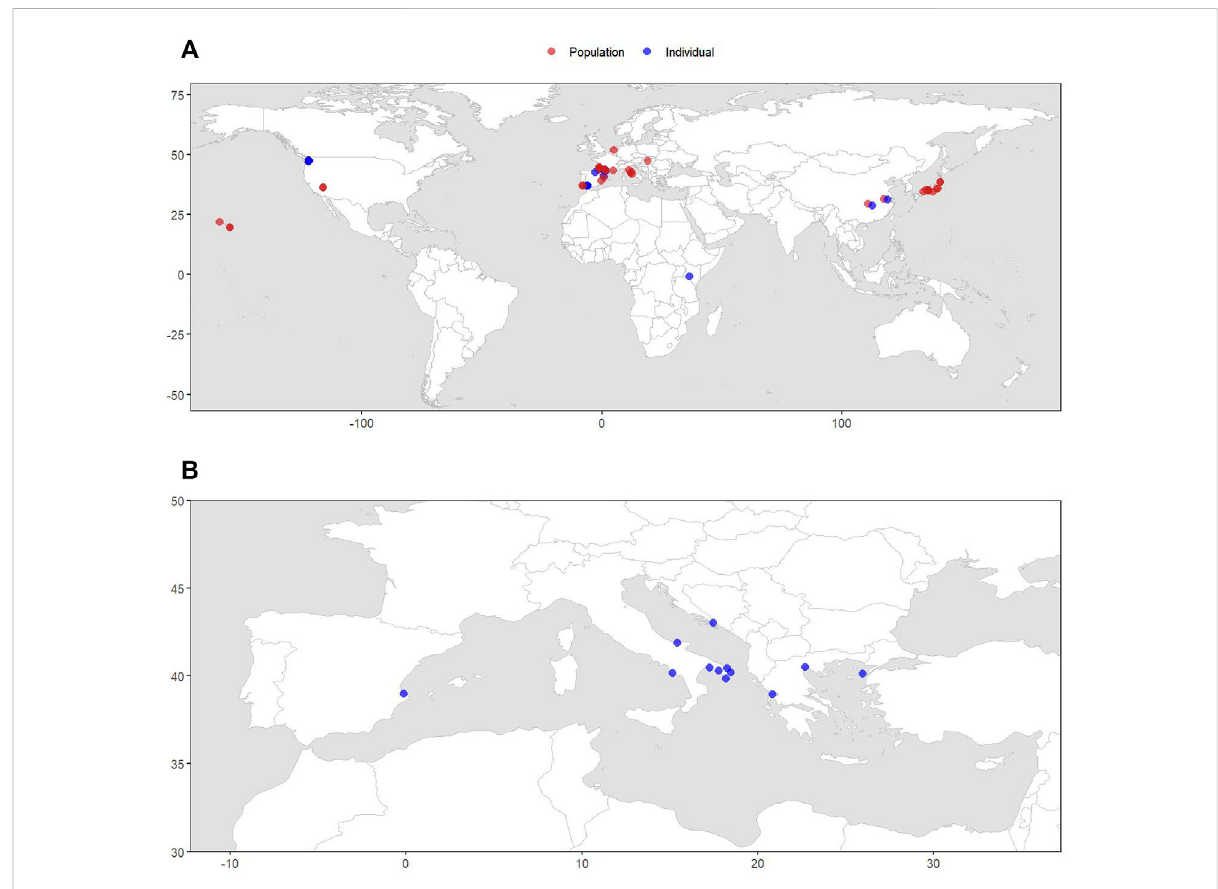
FIGURE 4 Mapsofthelocationsincludedinthedatasetsofstableisotopedatafor Procambarusclarkii (A) and Callinectessapidus (B) .Theisotopicrecords shown in red are resolved at population-scale and the ones in blue are resolved at